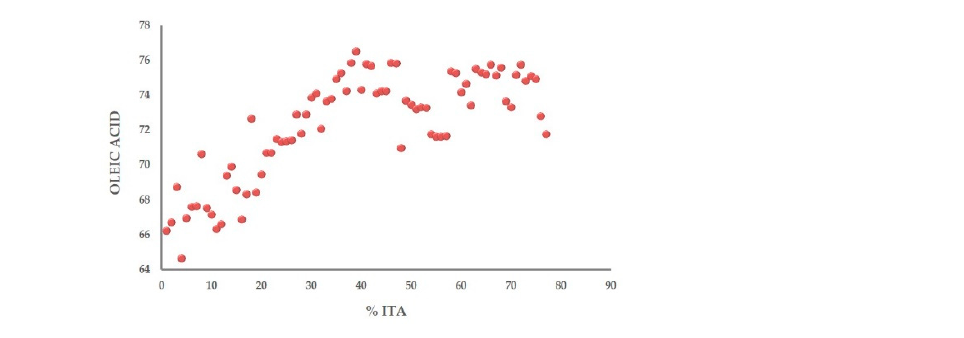
Figure 7. Quantification of oleic acid content correlated with the Italian component in the blends.